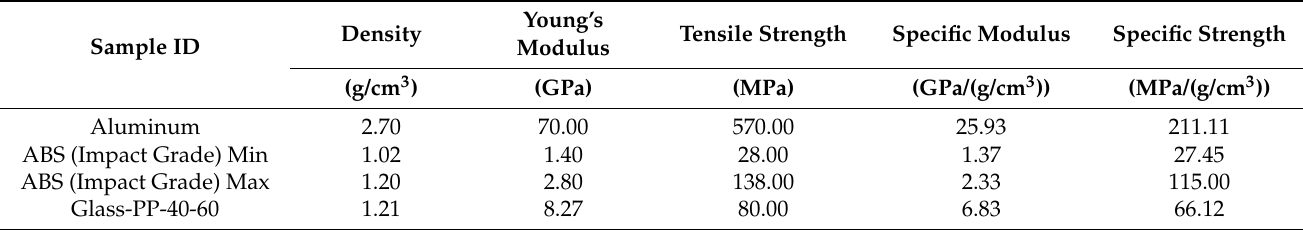
Table 11. Specific strength and specific modulus of other engineering materials.